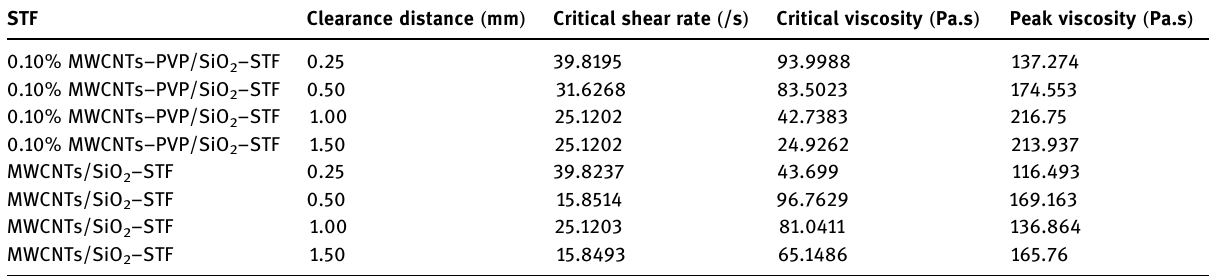
Table 2: The rheological characteristics of the two systems under di ff erent plate spacings STF Clearance distance ( mm ) Critical shear rate ( /s ) Critical viscosity ( Pa.s ) Peak viscosity ( Pa.s )